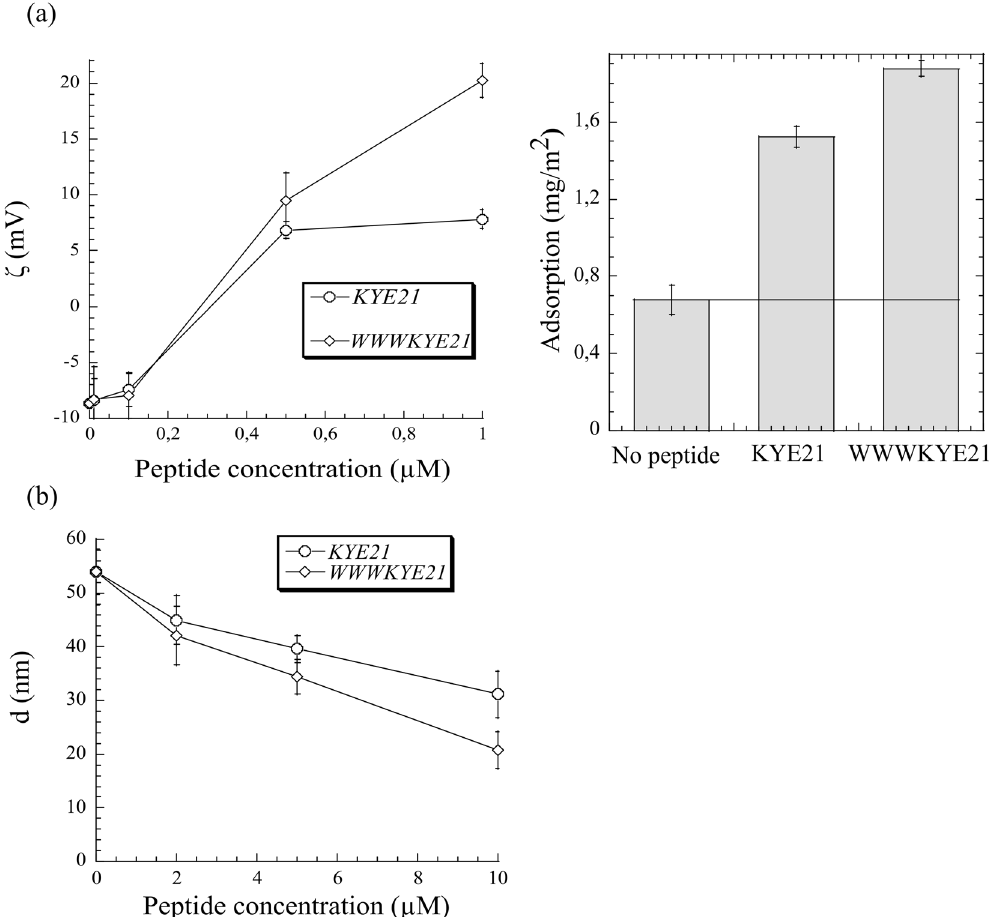
Figure 9. ( a ) Z-potential of DOPC/cholesterol (60/40 mol/mol) liposomes as a function of peptide concentration in 10 mM Tris, pH 7.4 (left), as well as LPS binding to DOPC/cholesterol bilayers after peptide pre-adsorption from 1 µ M (right). ( b ) Mean aggregate diameter for LPS-peptide complexes for KYE21 and WWWKYE21 in 10 mM Tris, pH 7.4. Measurements were performed at a fixed LPS concentration of 0.2 mg/ml, varying the peptide concentration. (n ≥